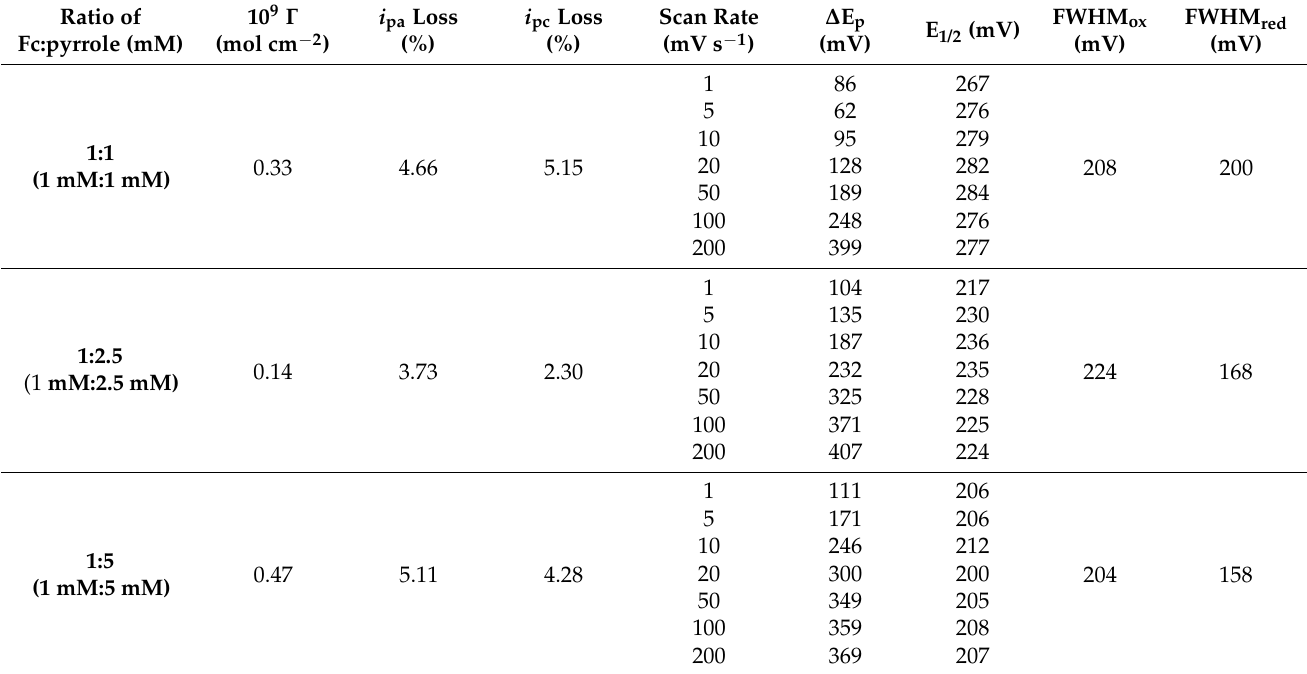
Table 1. Data from variable scan rate study on the films of 3-(1 H -pyrrol-1-yl)propanamidoferrocene ( 2 ) and pyrrole using CV. Ratio of